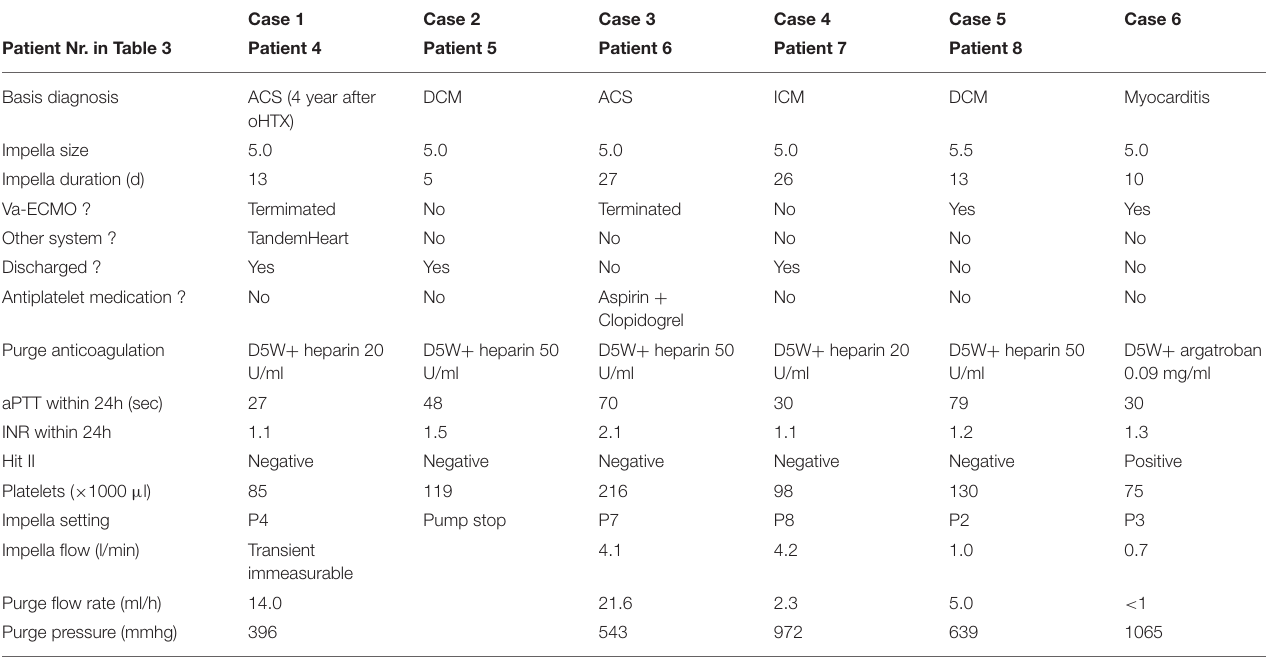
TABLE 6 | Clinical characteristics of 6 patients at the timing of pump